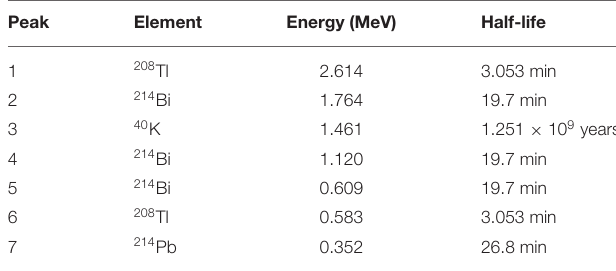
isotopes viz. 208 Tl, 214 Bi, 40 K, and 214 Pb. Different energy peaks are numbered and corresponding elements are